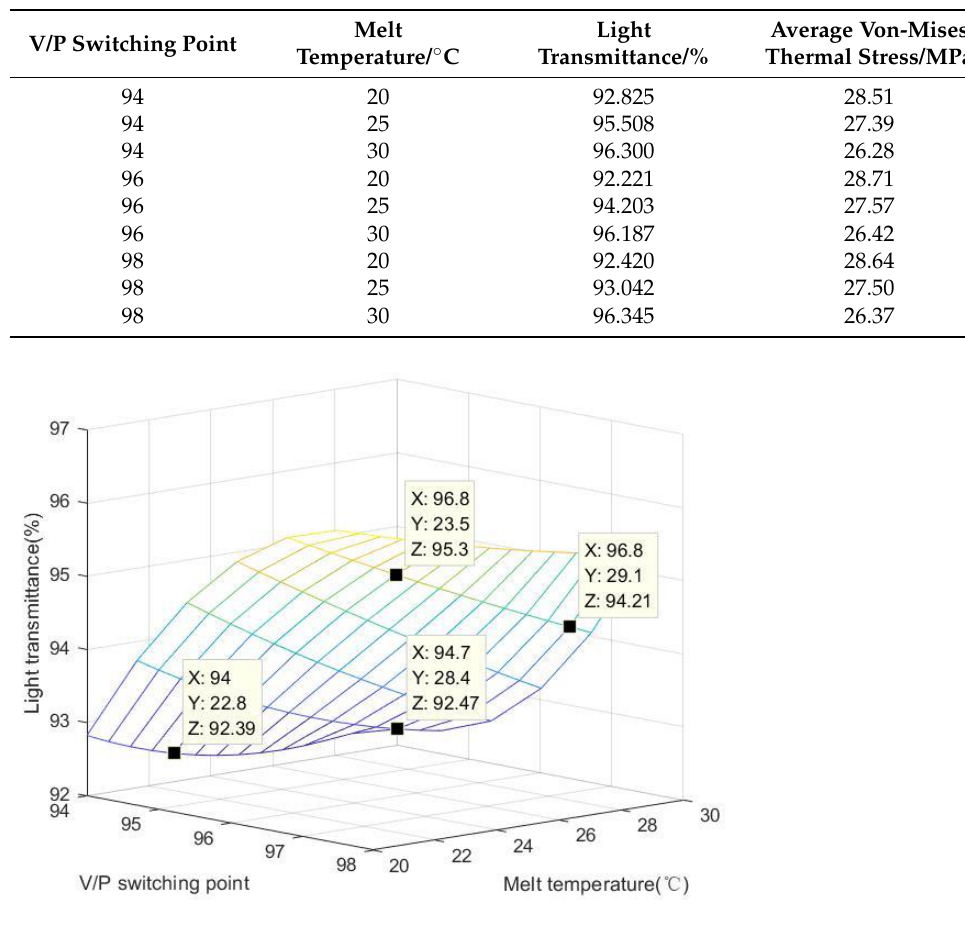
Figure 11. The relationship between V/P switching point, light transmittance and melt temperature. Table 6. Average Von-Mises thermal stress changes with melt